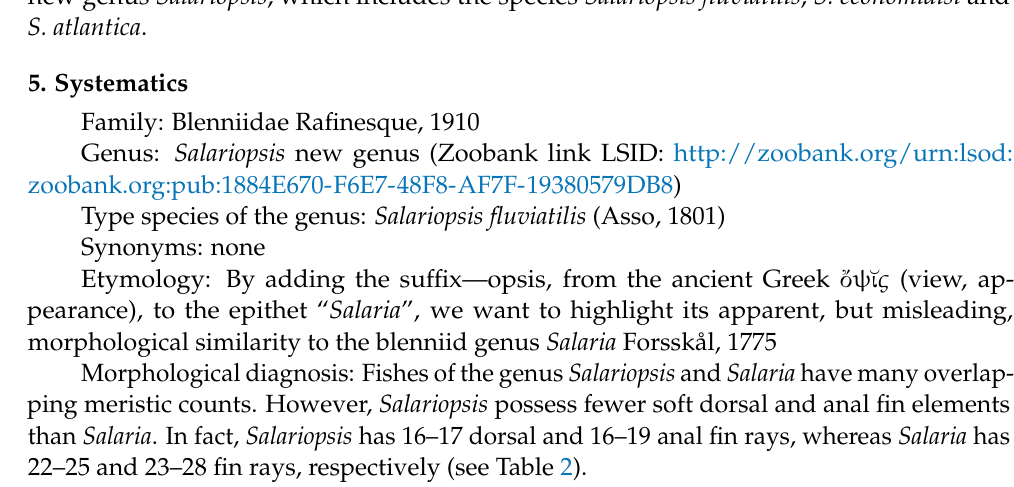
Table 2. Meristic data compiled from literature for comparison of fin element counts. Superscripts indicate source: a Bath [8], b Kottelat [37], c Doadrio et al. [33], and d Tiralongo [20]. Presence of two spines in the pelvic fins of Salaria atlantica could not be confirmed. Tiralongo [20] added two new observations from S. basilisca : a specimen with 28 anal fin rays and another with 2 pelvic fin rays. Species Dorsal Fin Anal Fin Pectoral Fin Pelvic Fin Salariopsis fluviatilis XII-XIII, 16–17